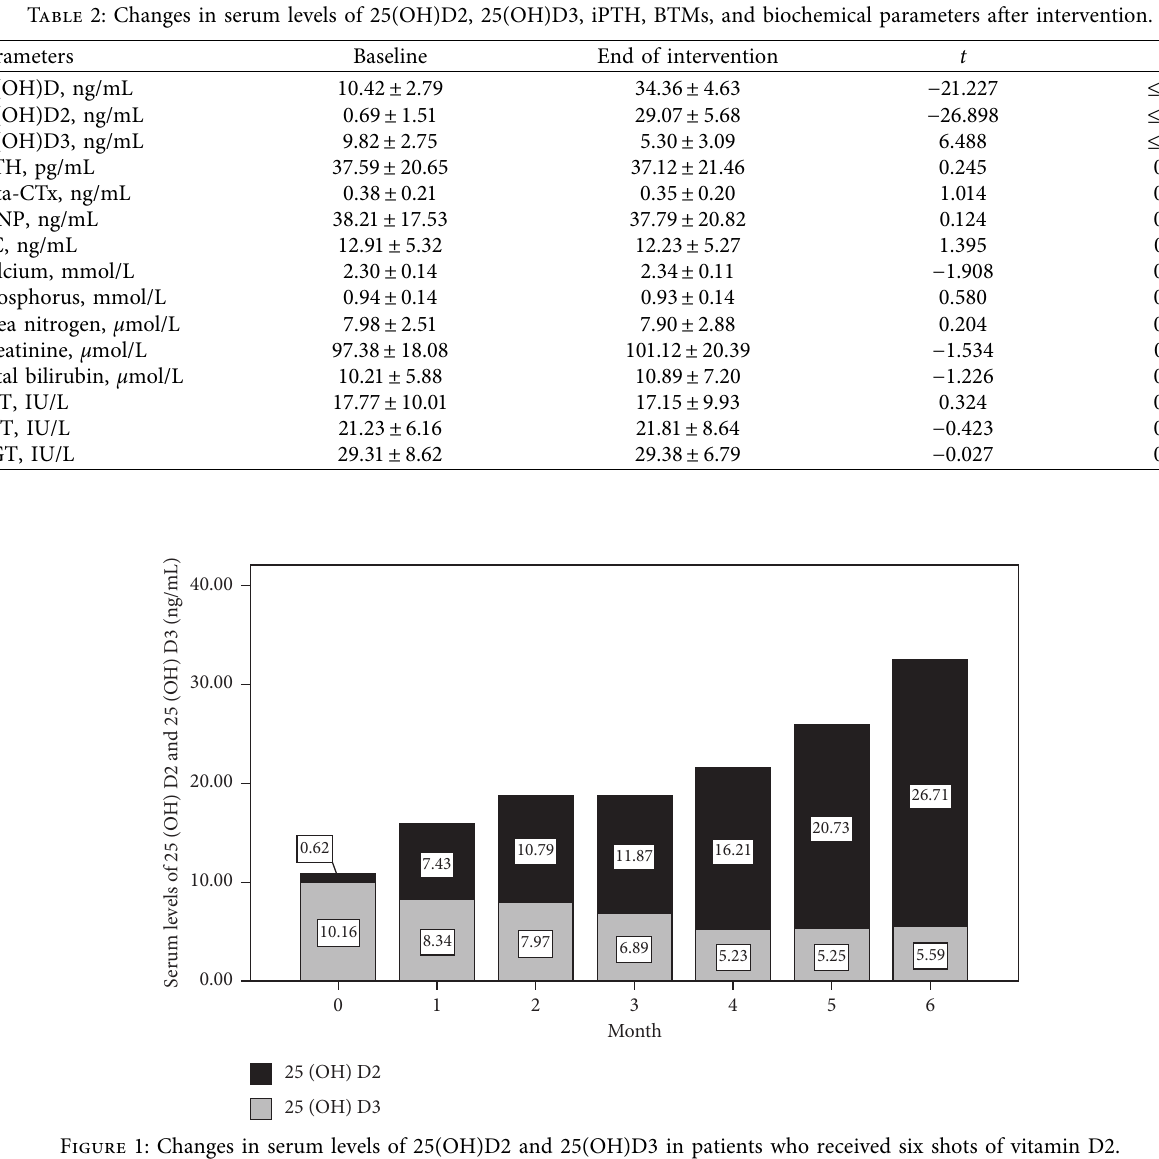
Figure 1: Changes in serum levels of 25(OH)D2 and 25(OH)D3 in patients who received six shots of vitamin